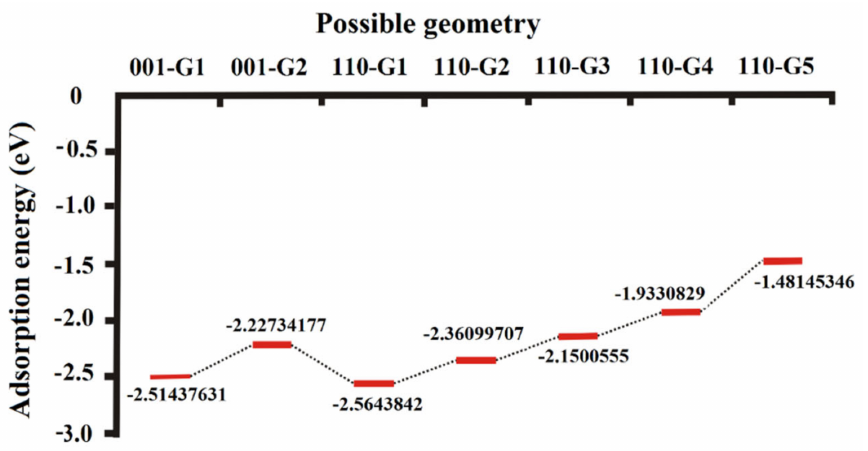
Figure 7. Adsorption energy of H 2 O at different adsorption sites on the (001) and (110)